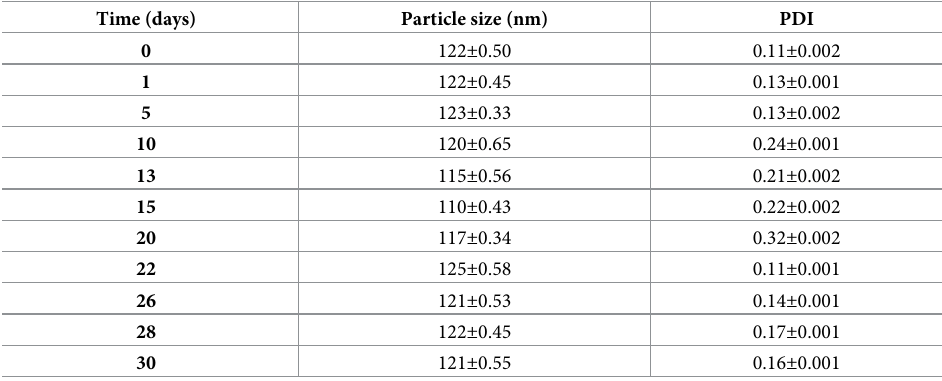
Table 2. Size and PDI changes of targeted bee venom-CSNPs stored in buffer solution at 4˚C.